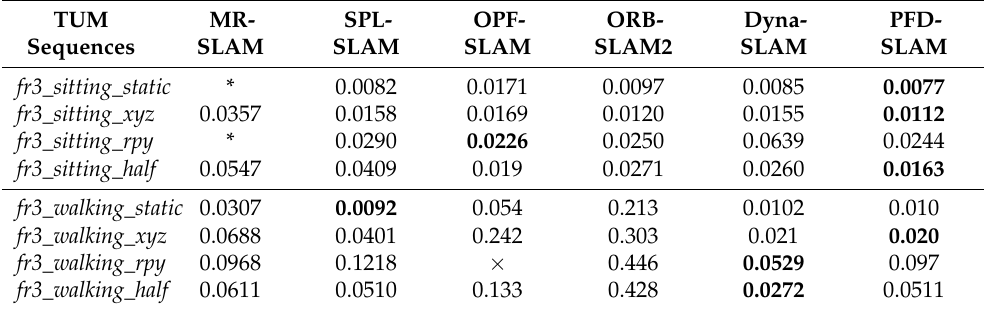
Table 3. Comparisons of RPE-RMSE (m/s) in translational drift on the TUM datasets.